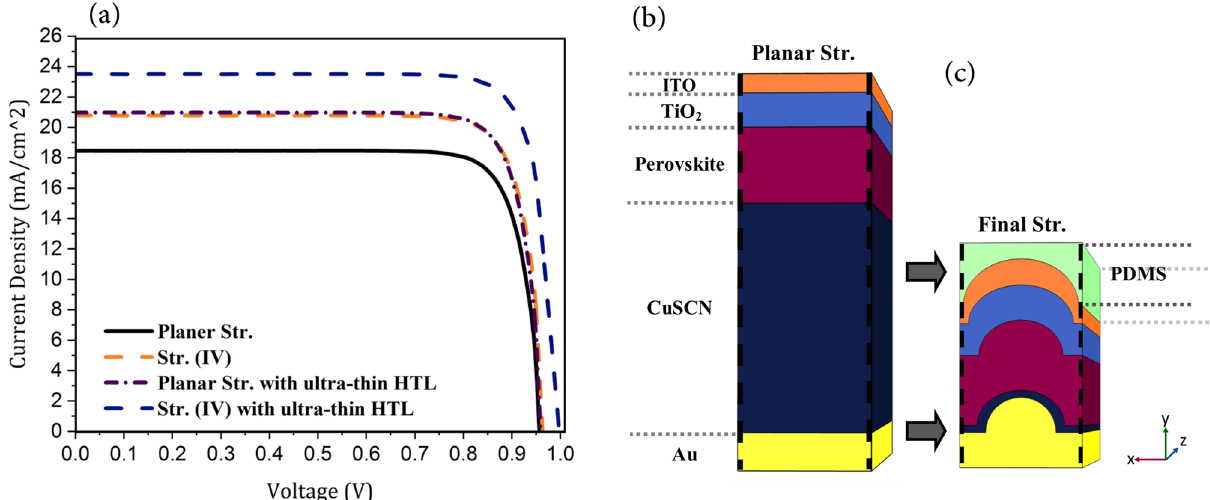
Fig. 11. ( a ) The current–voltage (J–V) characteristics of different structures and the final model of the proposed nanostructured PSC. ( a ) The J–V characteristics of planar and proposed structures of PSC. ( b ) The planar structure of a PSC. ( c ) The final model of the proposed nanostructured PSC (structure (IV) with ultra- thin HTL).